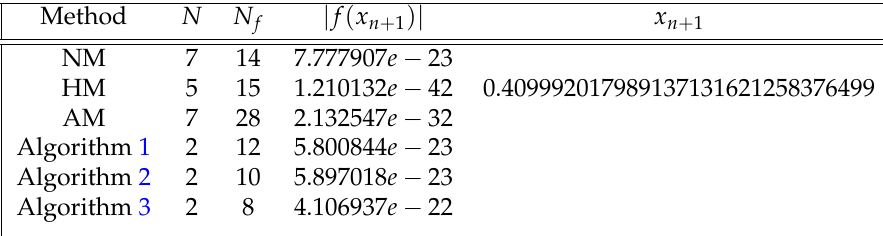
Table 6. Comparison of NM, HM, AM and Algorithms (1), (2) and (3)